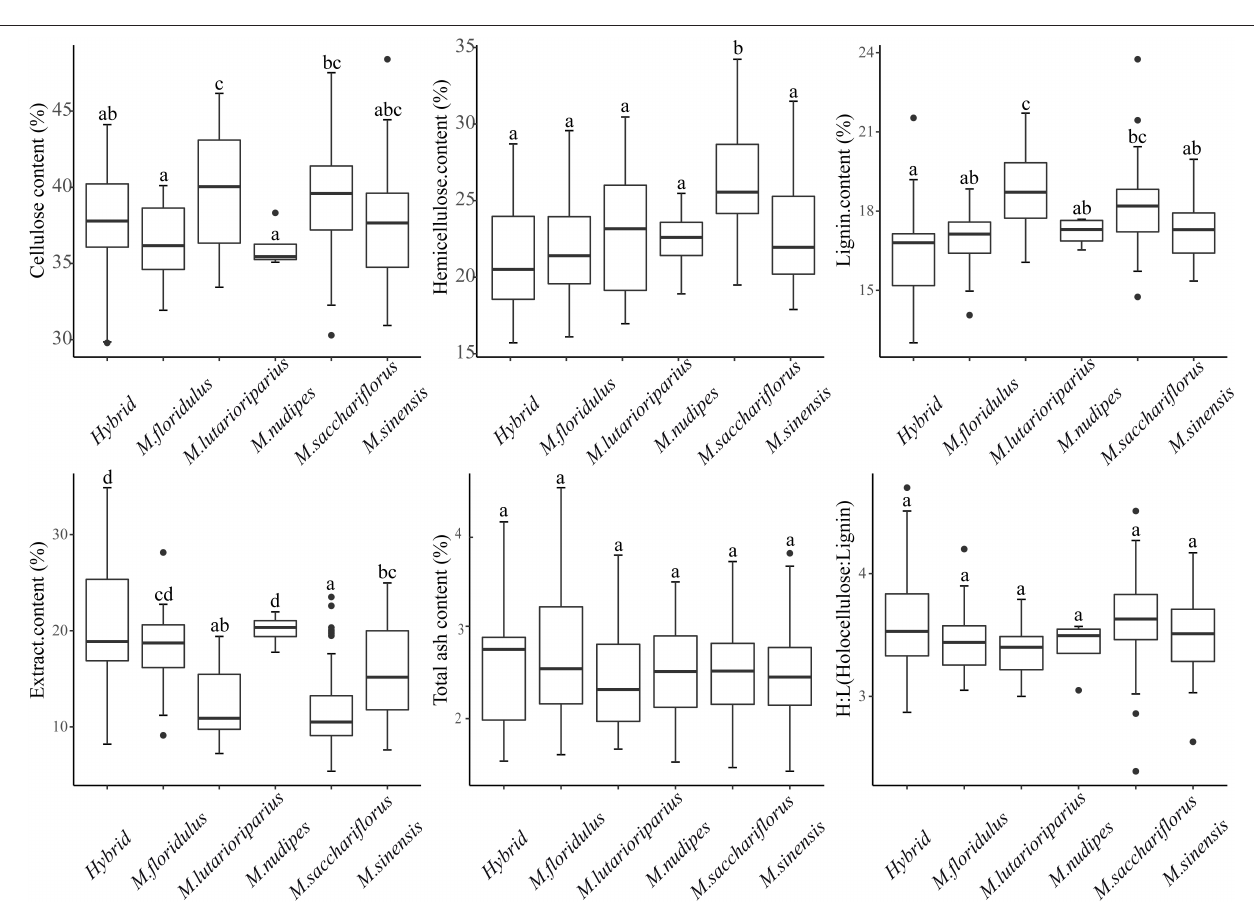
FIGURE 2 | Statistical comparison of stem components in different Miscanthus species. Different small letters indicate significant differences at the P < 0.05 level. The upper limit of Whisker represents the largest non-outlier value, and the lower limit is the smallest non-outlier value. The upper border line of the box represents the upper quartile, the middle line represents the median, and the lower border line represents the lower quartile. The dots around the box represent outliers.